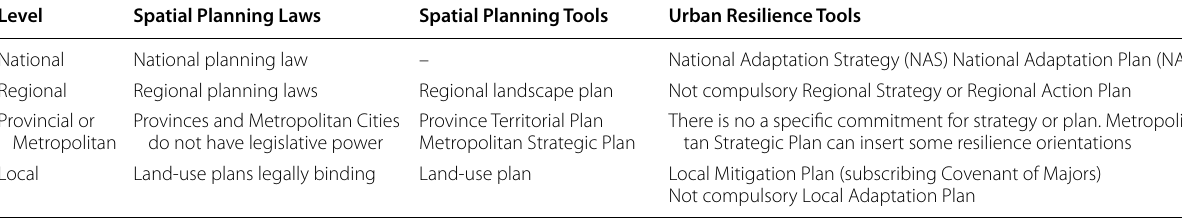
Table 3 Description of the Italian planning